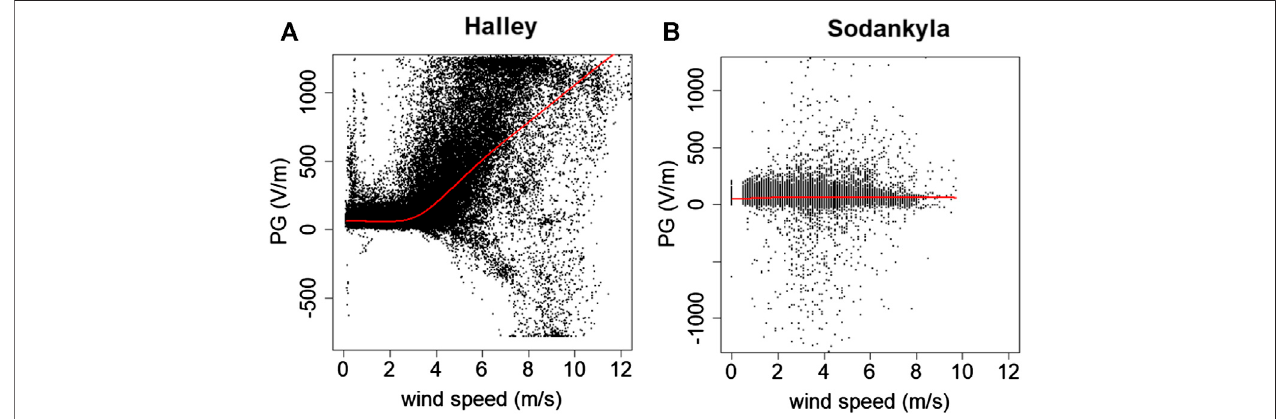
FIGURE3| RelationshipbetweenPGandwindspeedat (A) Halley,fortheentiredurationofthedataset,andat (B) Sodankylawhensnowdepthwas > 2 cm.Each point is a 10 min average value and the red line represents a lowess fi t to the data.